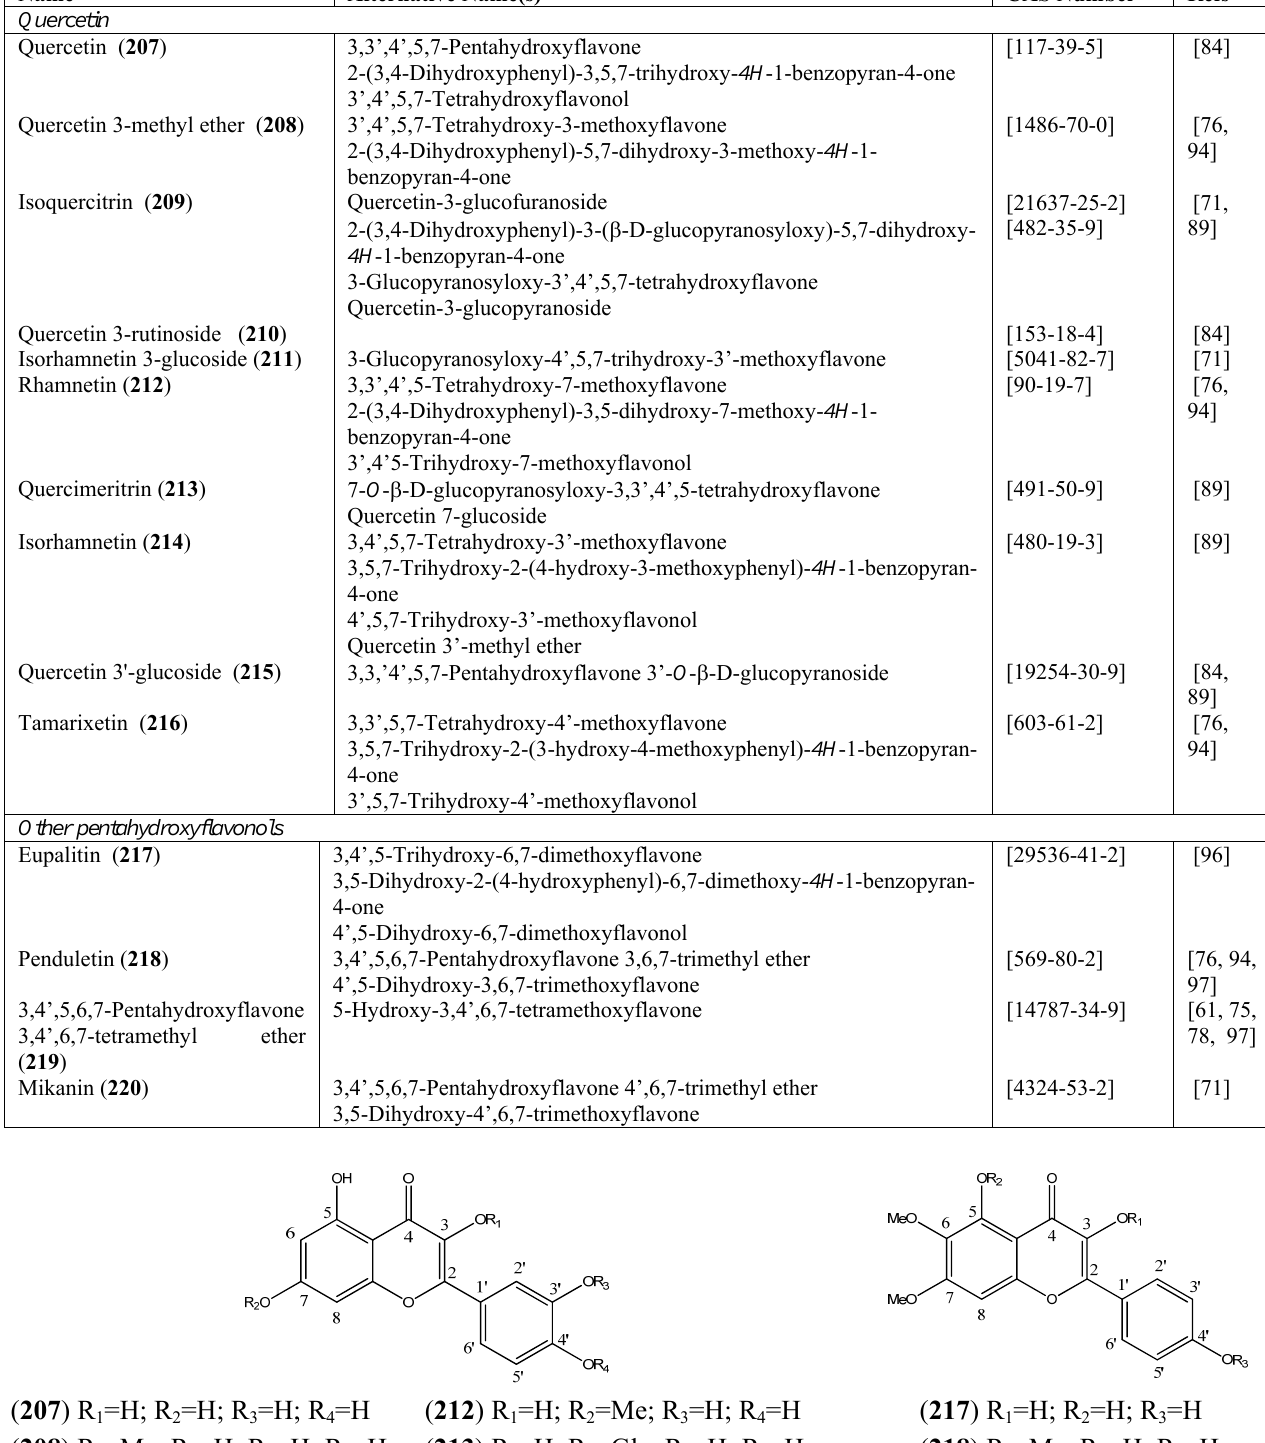
Table 20. Pentahydroxy